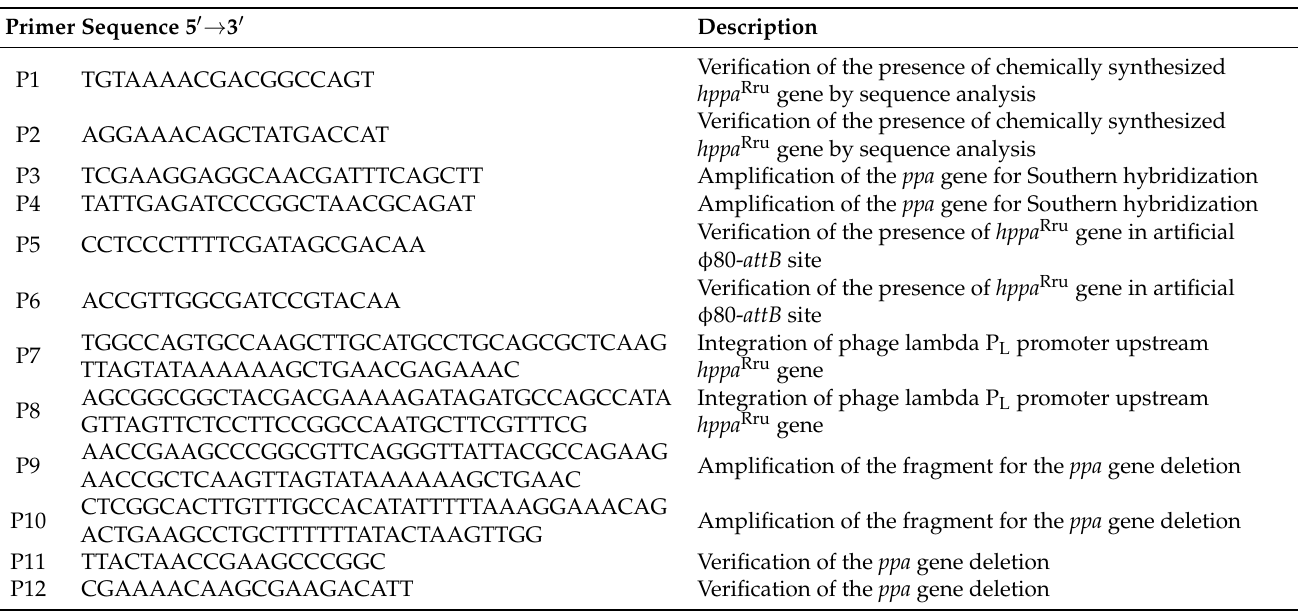
Table 2. Sequences of the PCR primers used in this